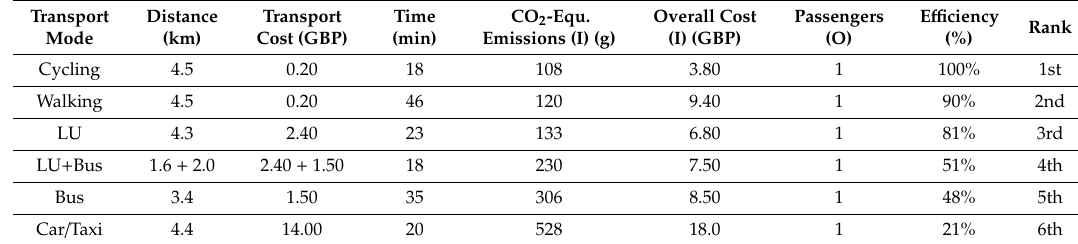
Table 4. Route B. Results in descending order of e ffi ciency of the transport modes DEA model.